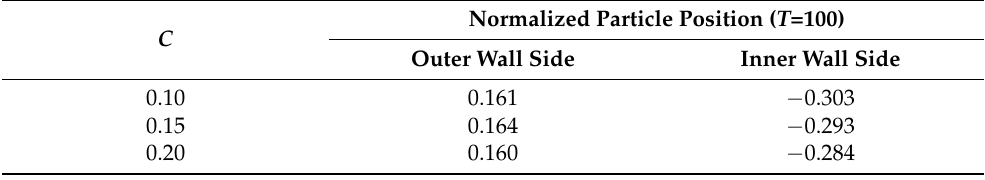
Figure 11. Particle migration for varying confinement 𝐶 with 𝑅𝑒 = 32 . ( a ) Particle migration on outer wall side. ( b ) Particle migration on inner wall side. Table 6. Value of particle position at 𝑇 = 100 for varying confinement 𝐶 = 0.10 ~0.20 with 𝑅𝑒 = 32 .